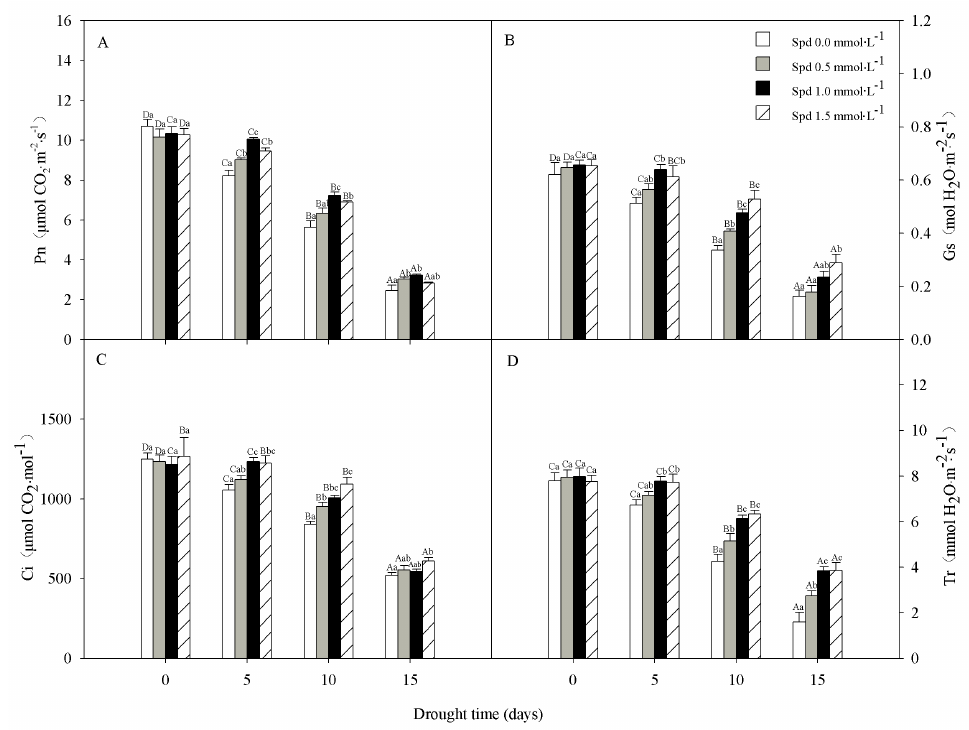
Figure 2. ( A ) Net photosynthetic rate (P N ), ( B ) stomatal conductance (Gs), ( C ) intracellular CO 2 concentration (Ci), and ( D ) transpiration rate (Tr) of Hordeum jubatum shoots not Spd treated (S0) or pretreated with 0.5 mM Spd (S1), 1.0 mM Spd (S2), and 1.5 mM Spd (S3) under drought stress. Days 0, 5, 10, and 15 correspond to CK, D1, D2, and D3 in the experimental treatment, respectively. The capital letters denote significant differences among the different drought intensities from the shoots under the same concentrations of Spd. The small letters denote significant differences among the different concentrations of Spd from shoots under the same drought intensity. The differences in each parameter were tested by a one − way analysis of variance (ANOVA) at the p < 0.05 level. The bars represent the means ± SEs (n =